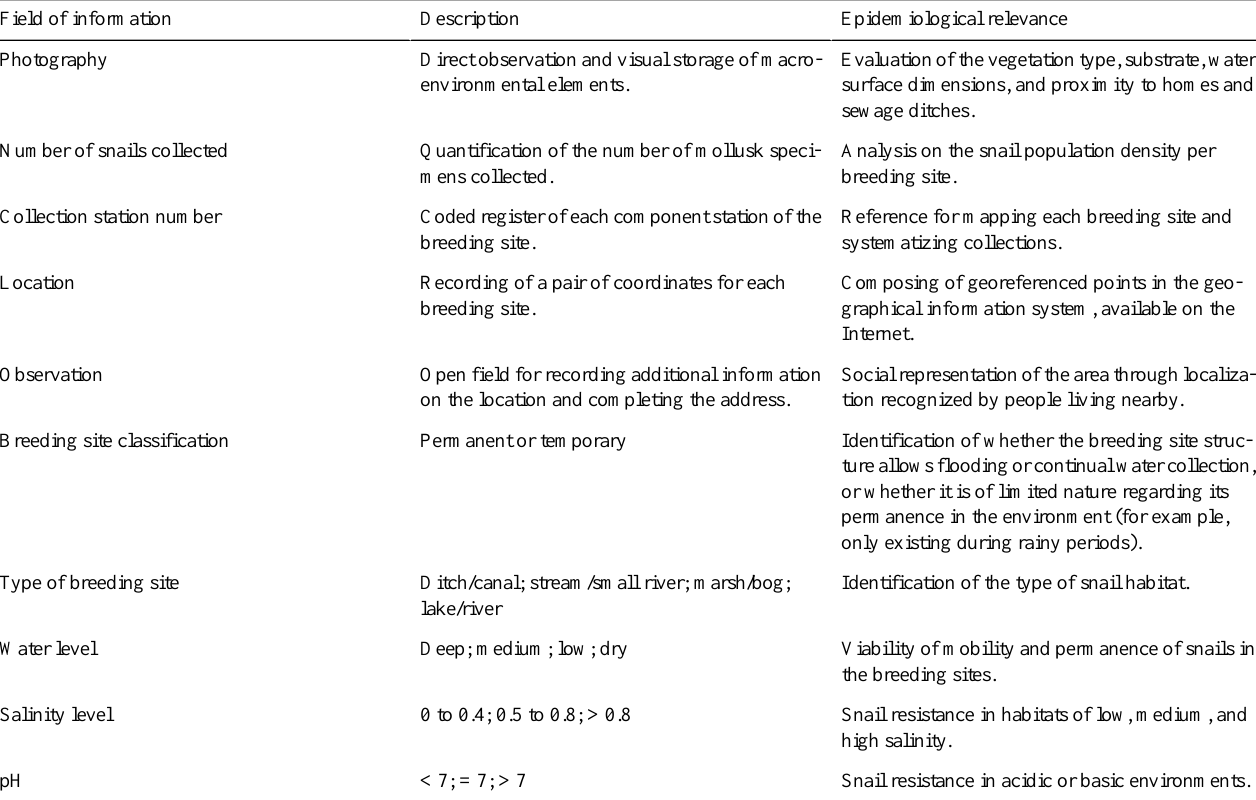
Table 1. Variables to be gathered for registering breeding sites and foci of vector mollusks.